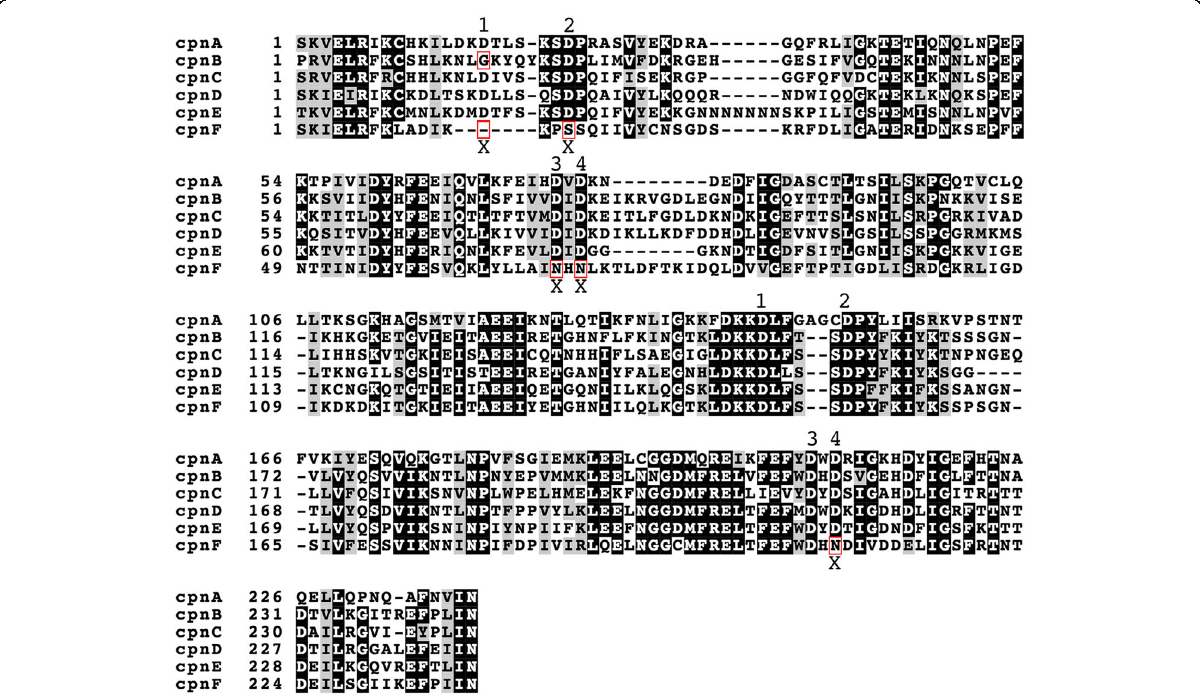
Fig. 8 The C2 domains of CpnF are missing key aspartates. The amino acids that make up the two C2 domains of the six Dictyostelium copines were identified using the NCBI Conserved Domain Search. The two C2 domains and intervening sequences for all the copines were aligned using Clustal Omega. BoxShade was used to indicate conserved residues within the aligned sequences. Black boxes indicate where at least five out of the six copines have the identical amino acid, while gray boxes indicate where at least five out of the six copines have a similar amino acid. Four key aspartates thought to be involved in calcium binding in each C2 domain are indicated with a number. Locations were these aspartates are missing are indicated with an X and highlighted with a red